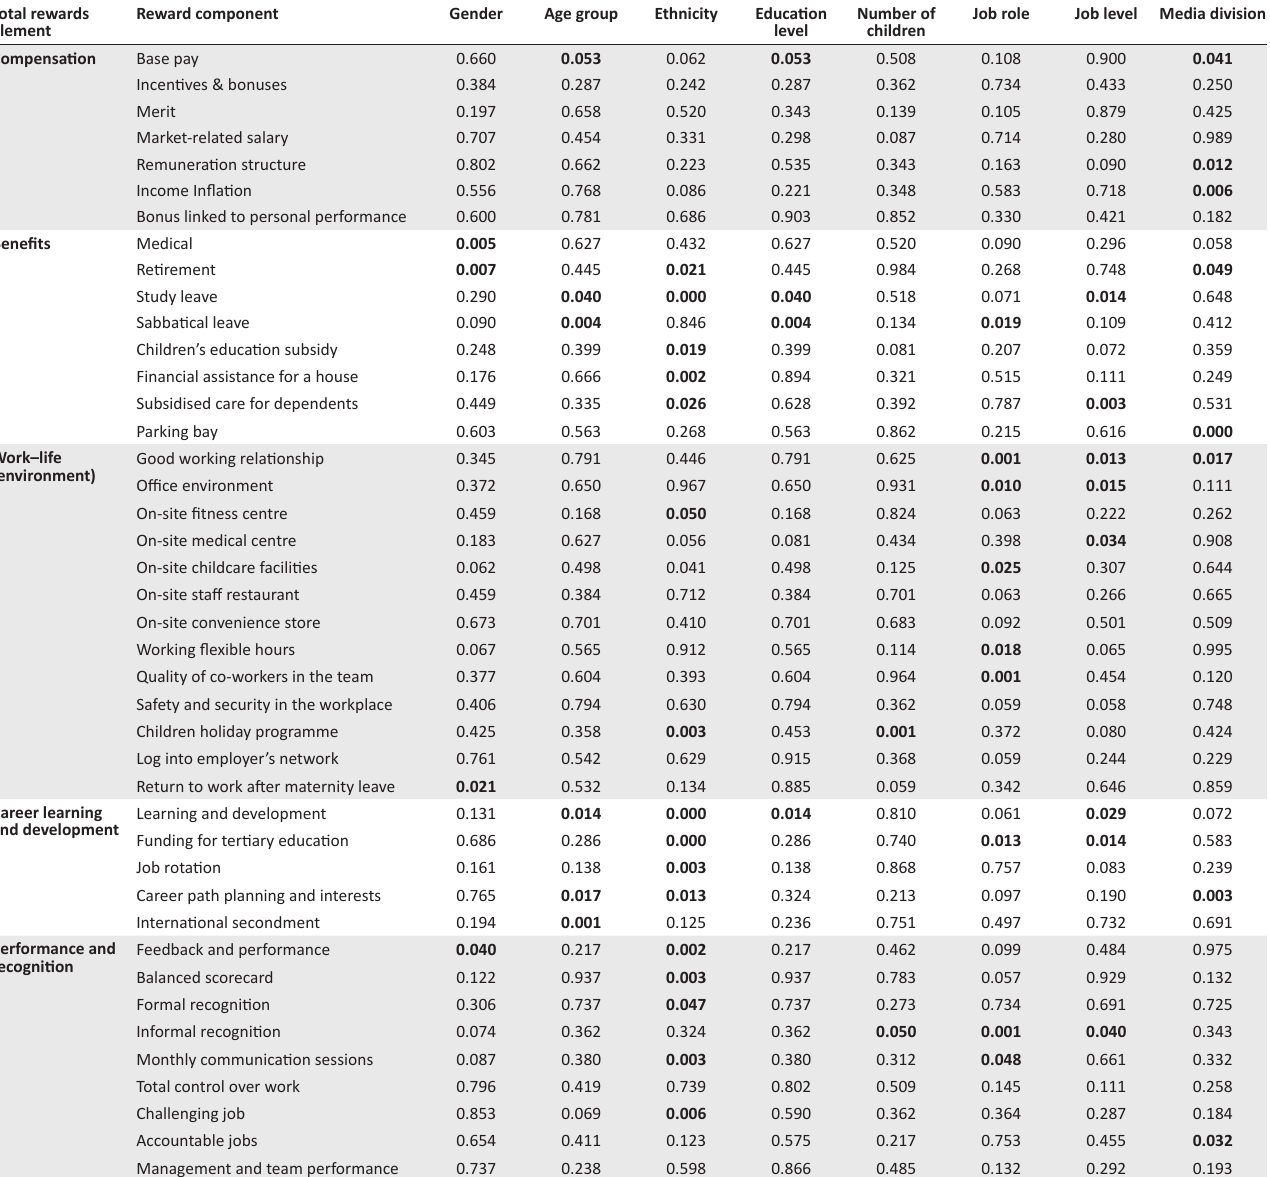
TABLE 1: Total reward preference comparisons by all